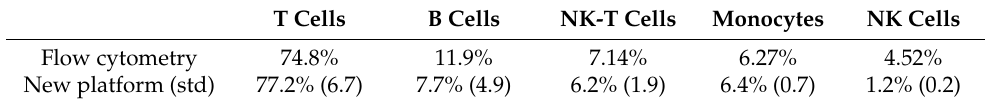
Table 1. Percentage of cells found by standard flow cytometry and by our system. T Cells B Cells NK-T Cells Monocytes NK Cells Flow cytometry